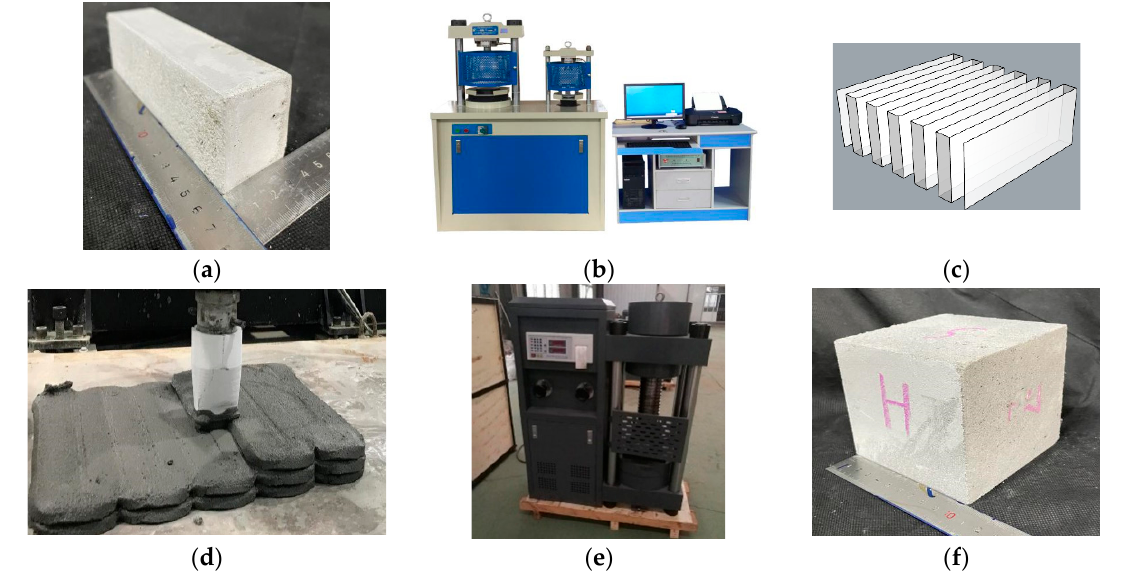
Figure 8. ( a ) Cast sample, ( b ) compression and flexure integrated testing machine (TYE-300E), ( c ) printing path model, ( d ) printing process, ( e ) compression testing machine (TYE-2000B), ( f ) printed sample.